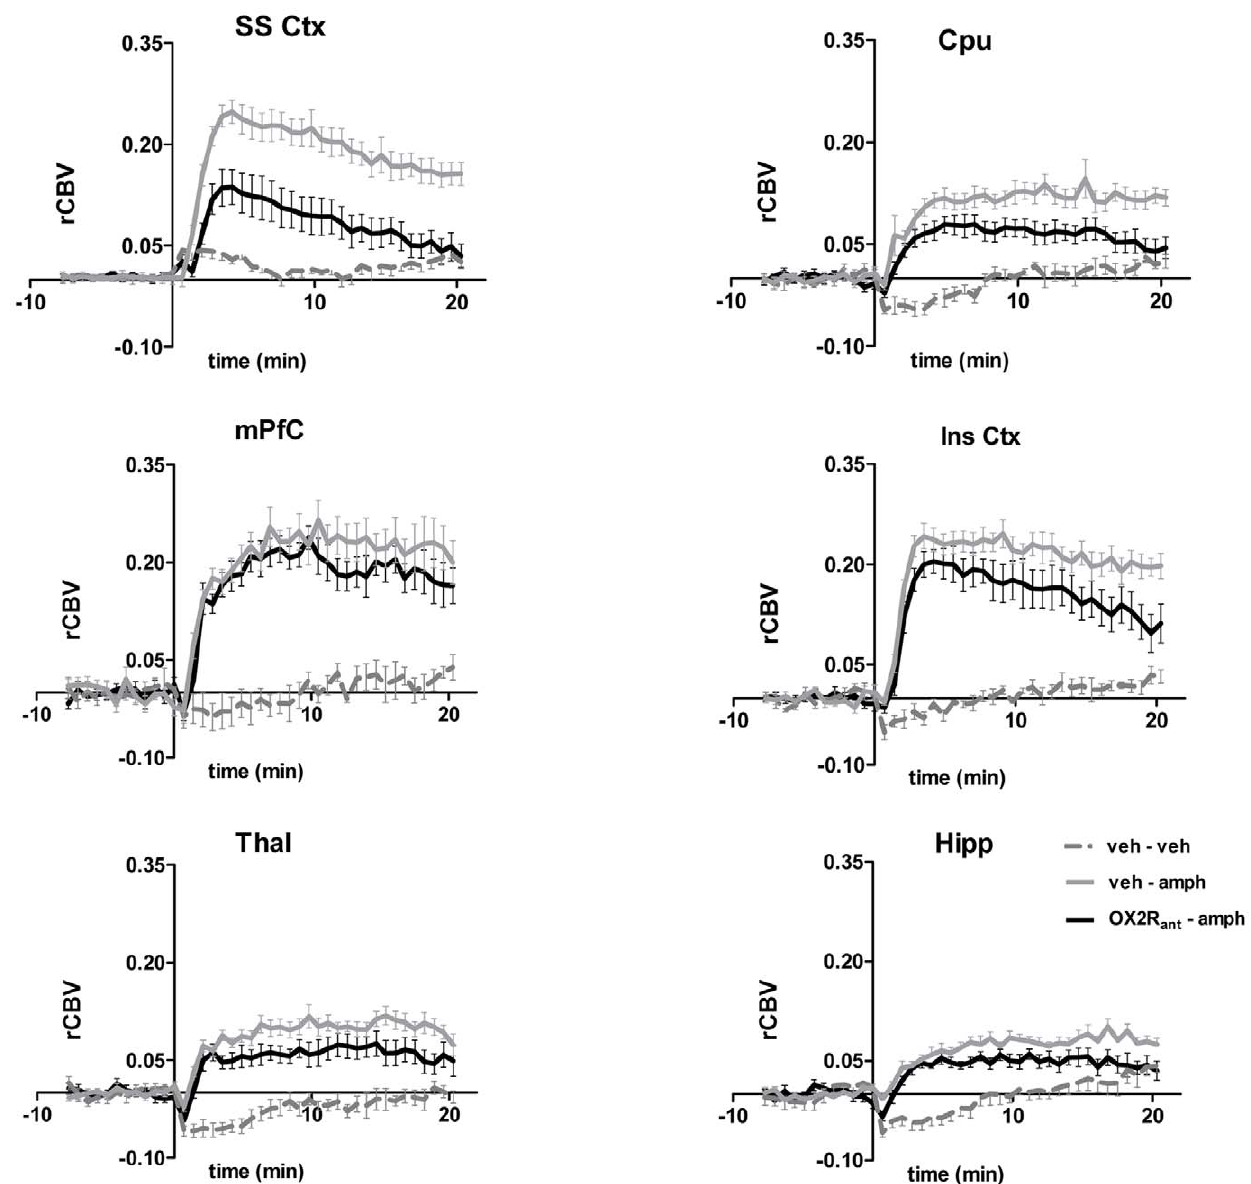
Figure 4. fMRI timecourse in representative brain regions: effect of OX2R antagonism. Temporal-profile of amphetamine-induced rCBV changes in representative VOIs. Data are plotted as mean 6 SEM within each group. OX2R ant: : JNJ10397049 (50 mg/kg i.p.) [SS Ctx: somatosensory cortex; Cpu: caudate putamen; mPFC: medial prefrontal cortex; Ins Ctx; insular cortex; Thal; thalamus; Hipp: hippocampus].